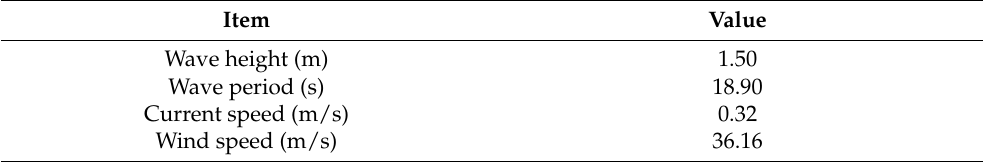
Table 7. Environmental conditions for structural frequency response analysis.